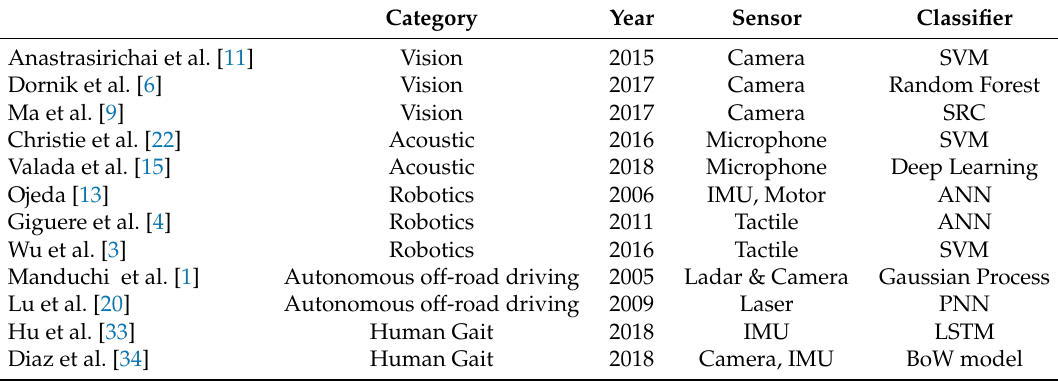
Table 1. A summary of the main approaches in terrain classification. A variety of sensors are used for data collection including camera, microphone, inertial measurement units (IMU), laser, tactical and ladar sensors. For classification, different types of classifier are proposed including Random Forest, Support Vector Machine (SVM), Sparse Representation Based Classification (SRC), Artifical